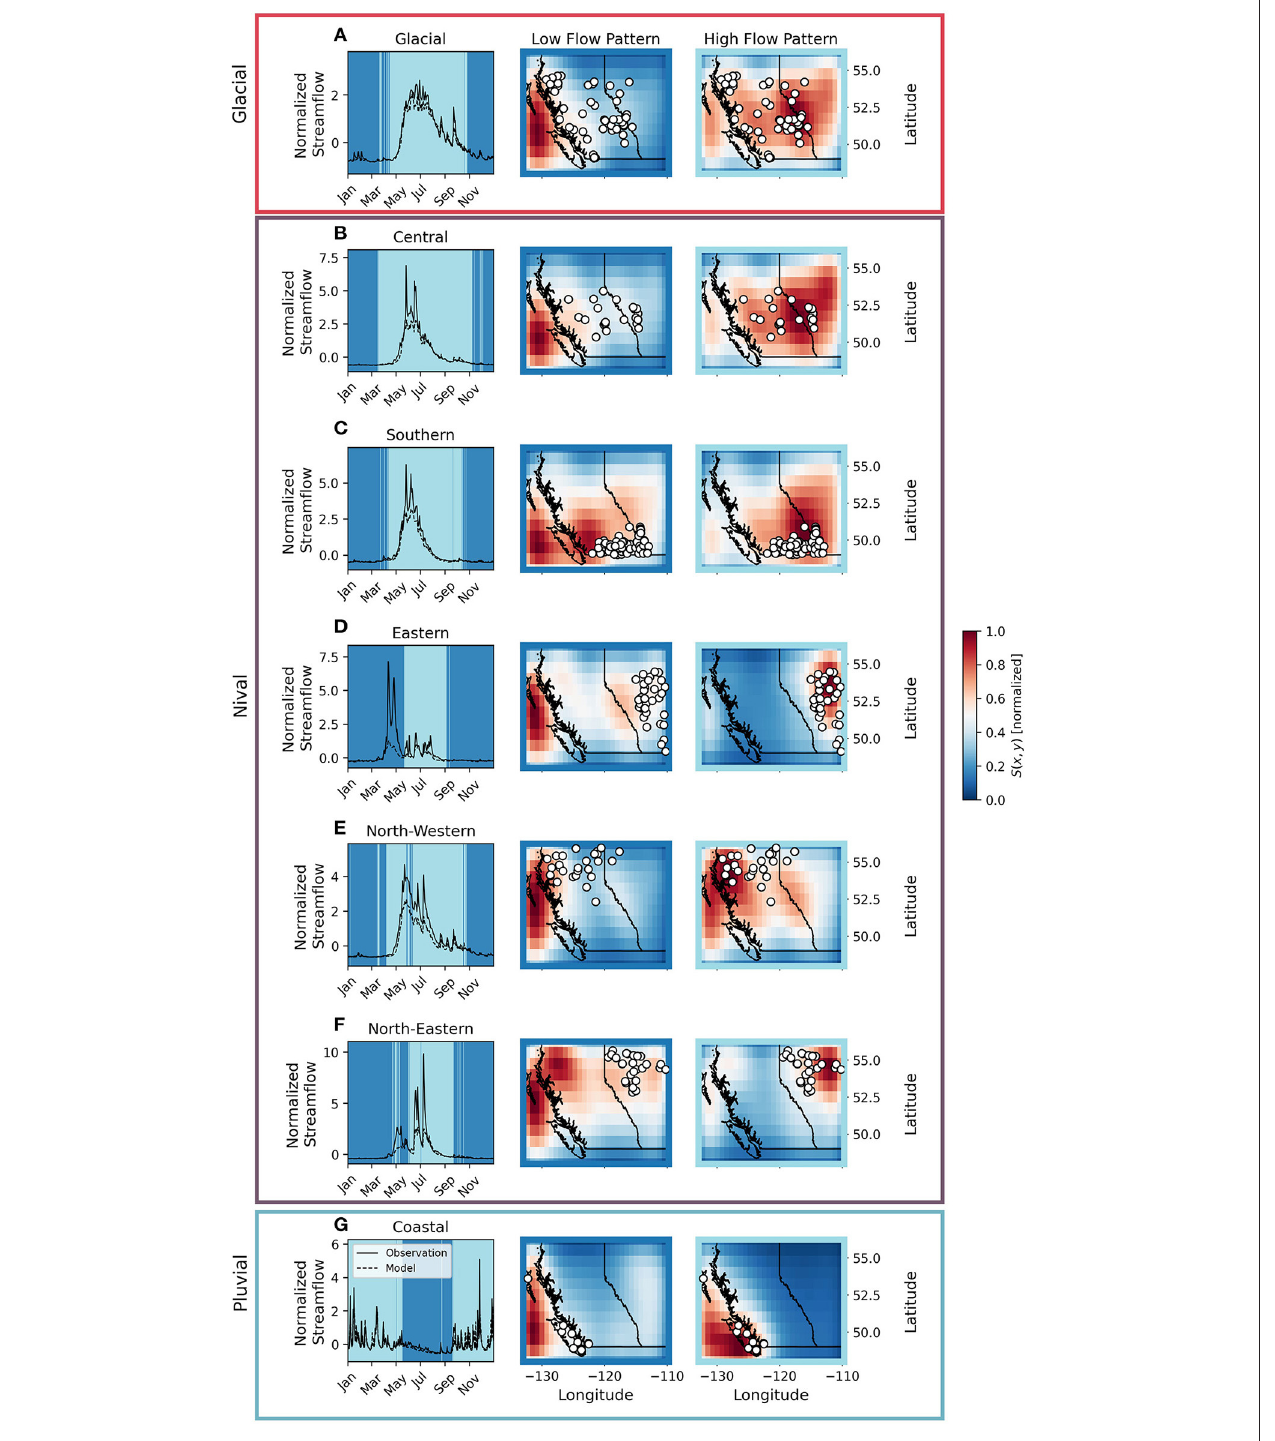
FIGURE 4 | The two characteristic patterns of spatial sensitivity and their occurrence through time for each of the six streamflow clusters. Rows (A–G) display results for nival, glacial, and pluvial sets of stream gauges. Left column: modeled and observed mean streamflow as spatially averaged across stations belonging to the cluster (white circles). Middle column: the “low-flow” sensitivity pattern S(x,y); red indicates areas with high sensitivity to perturbations in input fields. The occurrence of this “low-flow” pattern in time is shown by a dark blue shaded area in the left panel. Right column: the “high-flow” sensitivity pattern S(x,y). The occurrence of this “high-flow” pattern in time is shown by a light blue shaded areas in the left panel. Each sensitivity map S(x,y) is normalized to have a minimum value of 0 and a maximum value of 1.